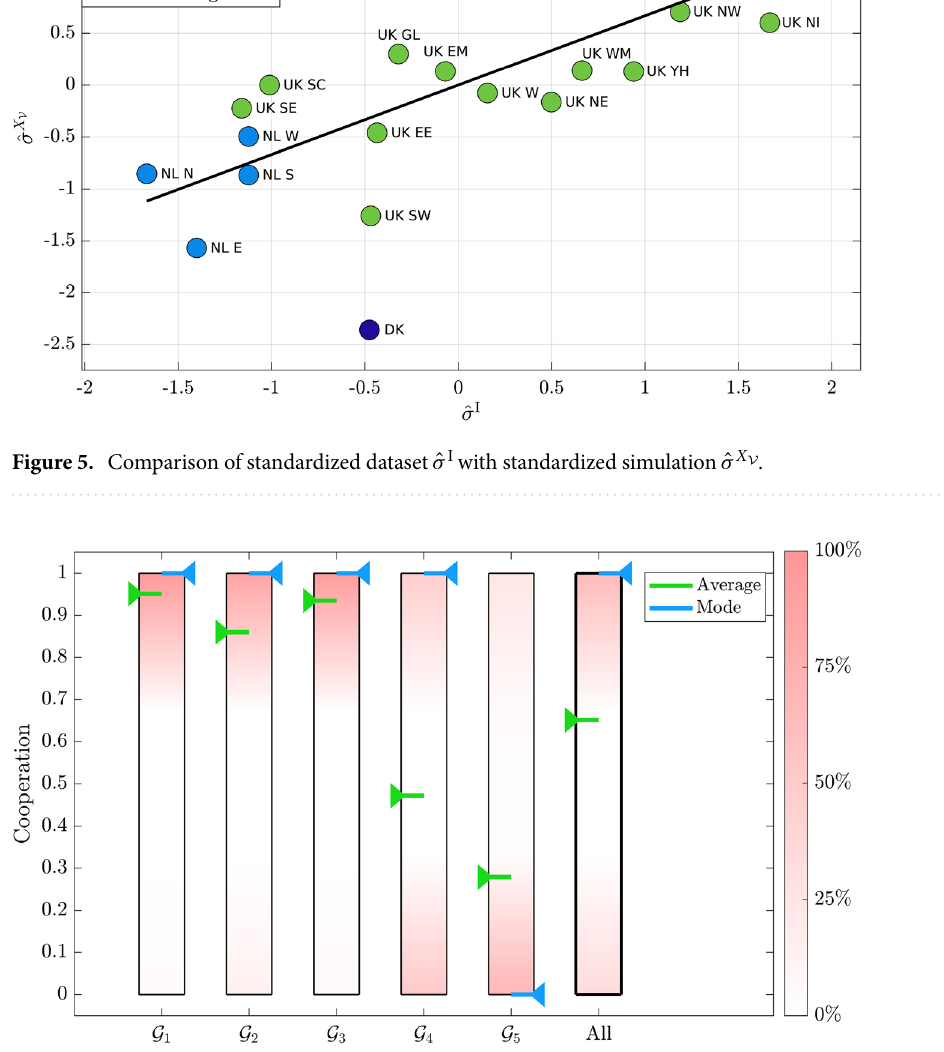
Figure 6. Distribution of the cooperation level of each group and of the whole population. Data refer to the asymptotic cooperation of players belonging to all 22 regions, obtained by the 100